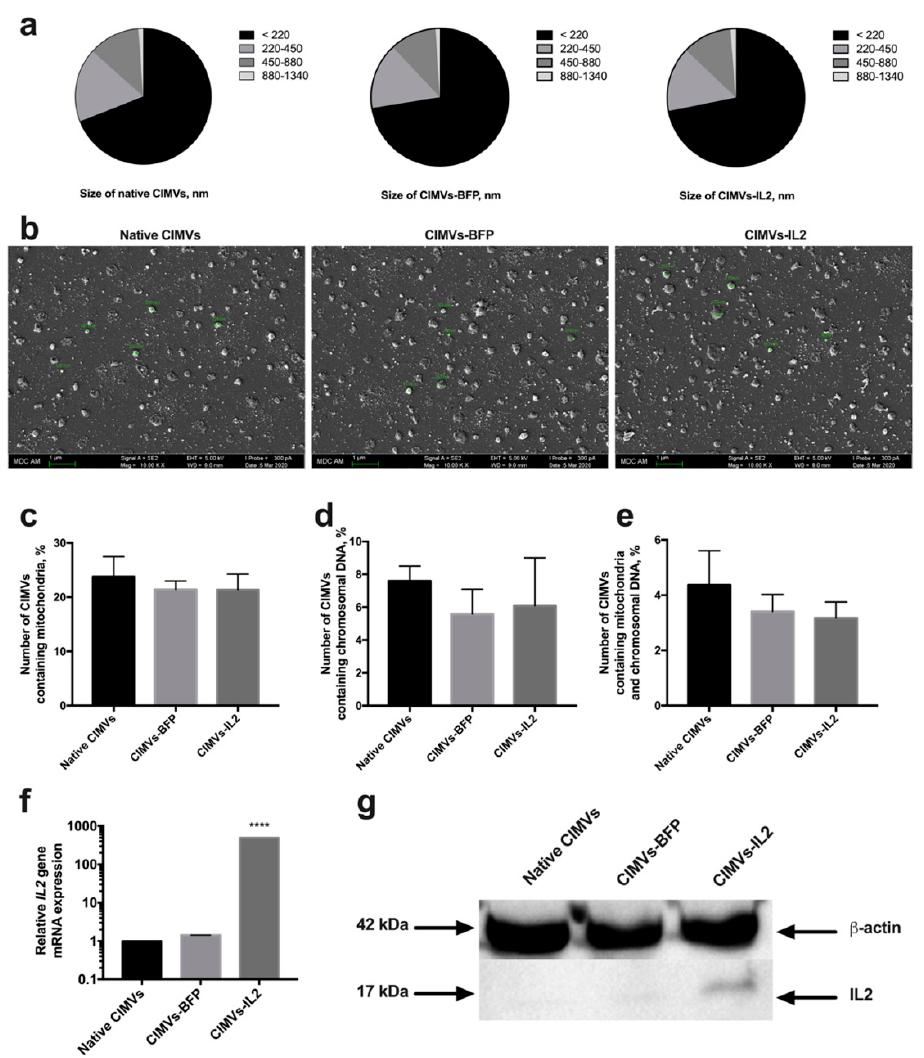
Figure 4. The size of cytochalasin B-induced membrane vesicles (CIMVs) was analyzed using flow cytometry ( a ) with calibrating beads as well as scanning electron microscopy ( b ) finding the majority of the CIMVs were less then 220 nm in diameter. The scale bar is 1 µ m. Analysis of the presence of the mitochondrial component showed the presence of mitochondria stained with MitoTracker Green in 23% of the isolated CIMVs ( c ). The presence of a nuclear component stained with the Hoechst 33,342 vital fluorescent dye was detected in 6% of the isolated CIMVs ( d ). The number of CIMVs